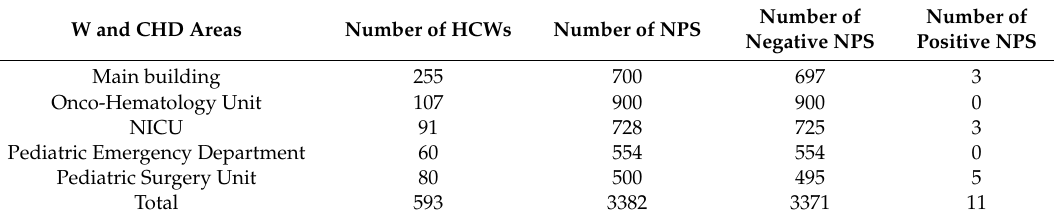
Table 1. Summary of NPS HCWs surveillance.